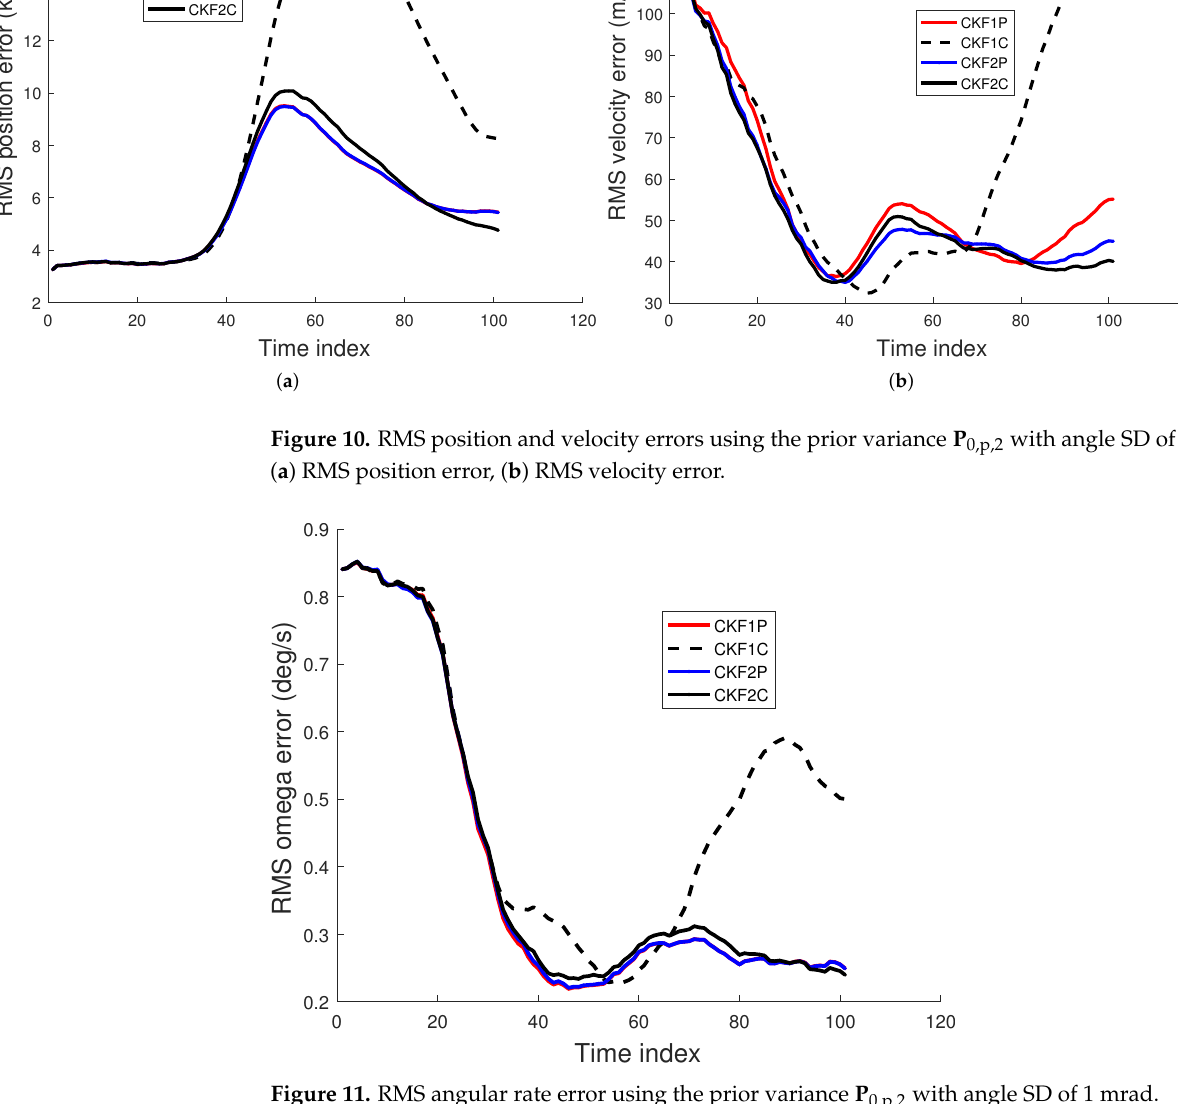
Figure 11. RMS angular rate error using the prior variance P 0,p,2 with angle SD of 1